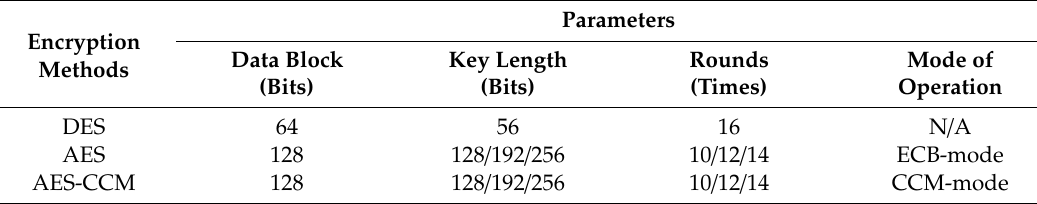
Table 3. Comparison of encryption